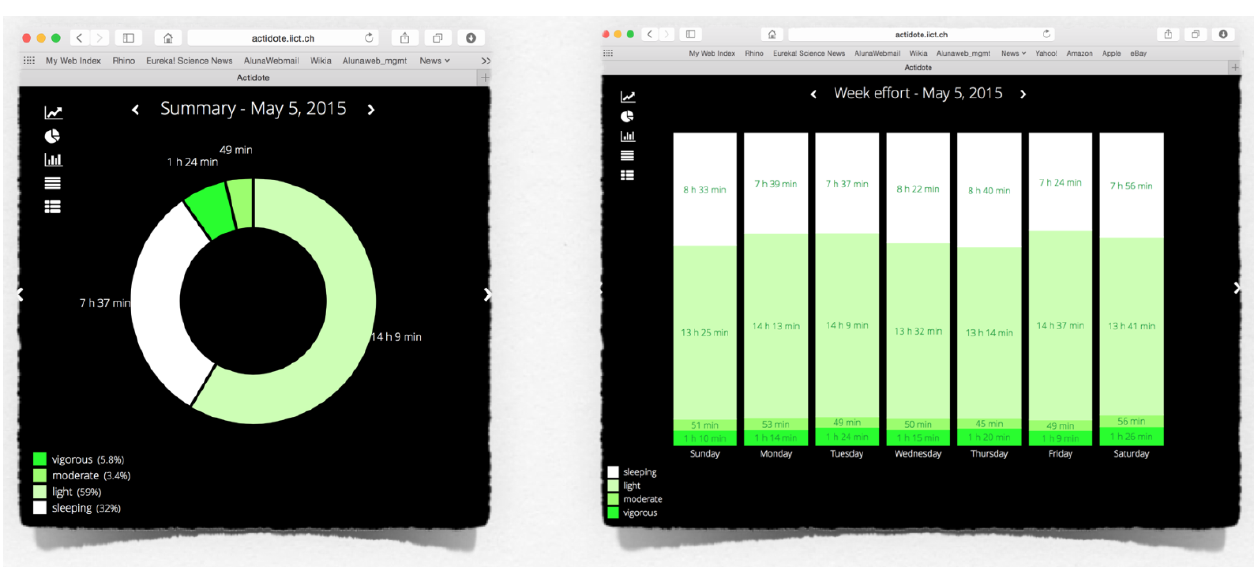
Figure 8. The web interface for the end user